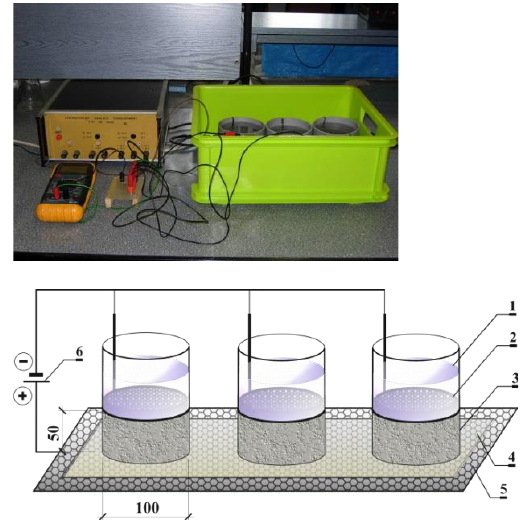
Figure 2. View and diagram of the test stand used in the experiment carried out according to the thermodynamic model of migration [42]: 1 — plastic tanks filled with 3% NaCl solution, 2 — cathode made of stainless steel, 3 — concrete element, 4 — damp sponge, 5 — platinum-coated titanium mesh